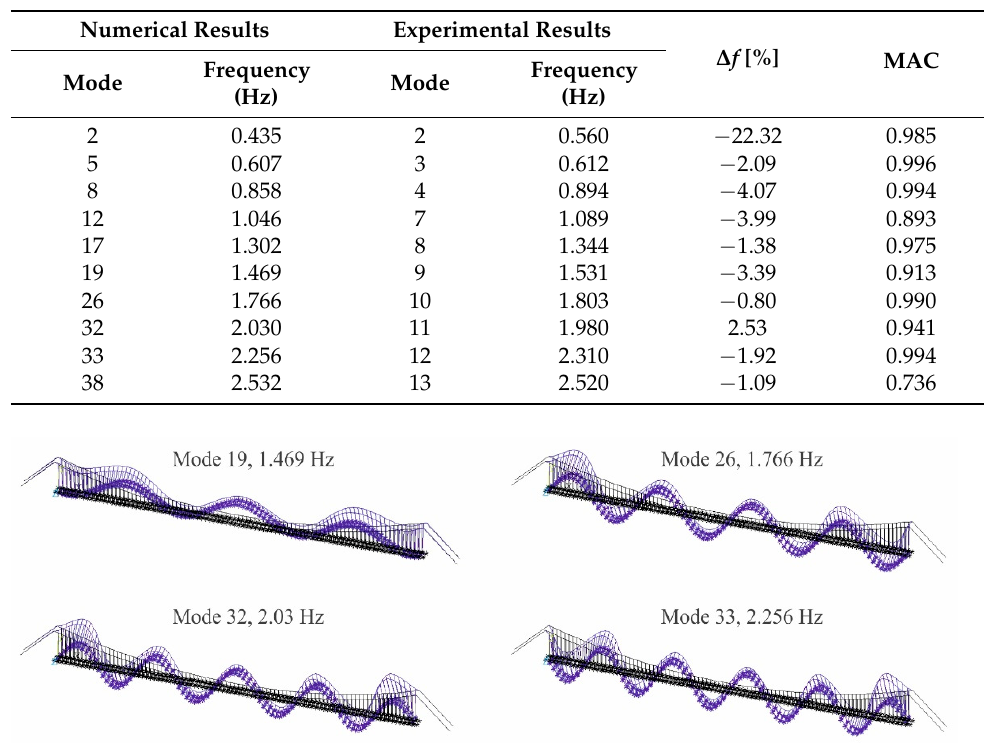
Table 8. Comparison of numerical and experimental modal parameters for bending vibration modes.